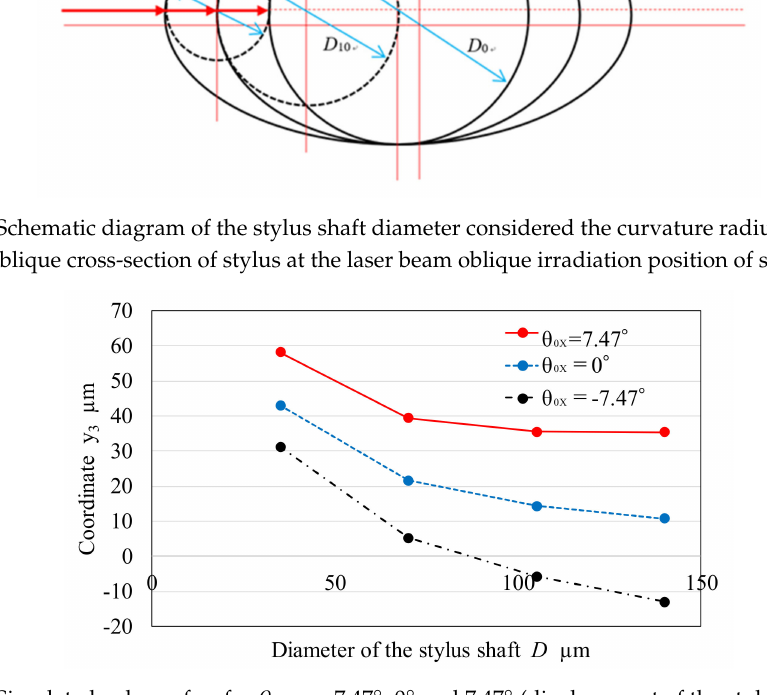
Figure 8. Simulated values of y 3 for θ 0X = − 7.47 ◦ , 0 ◦ and 7.47 ◦ (displacement of the stylus shaft along Y-axis = 0.03 µ